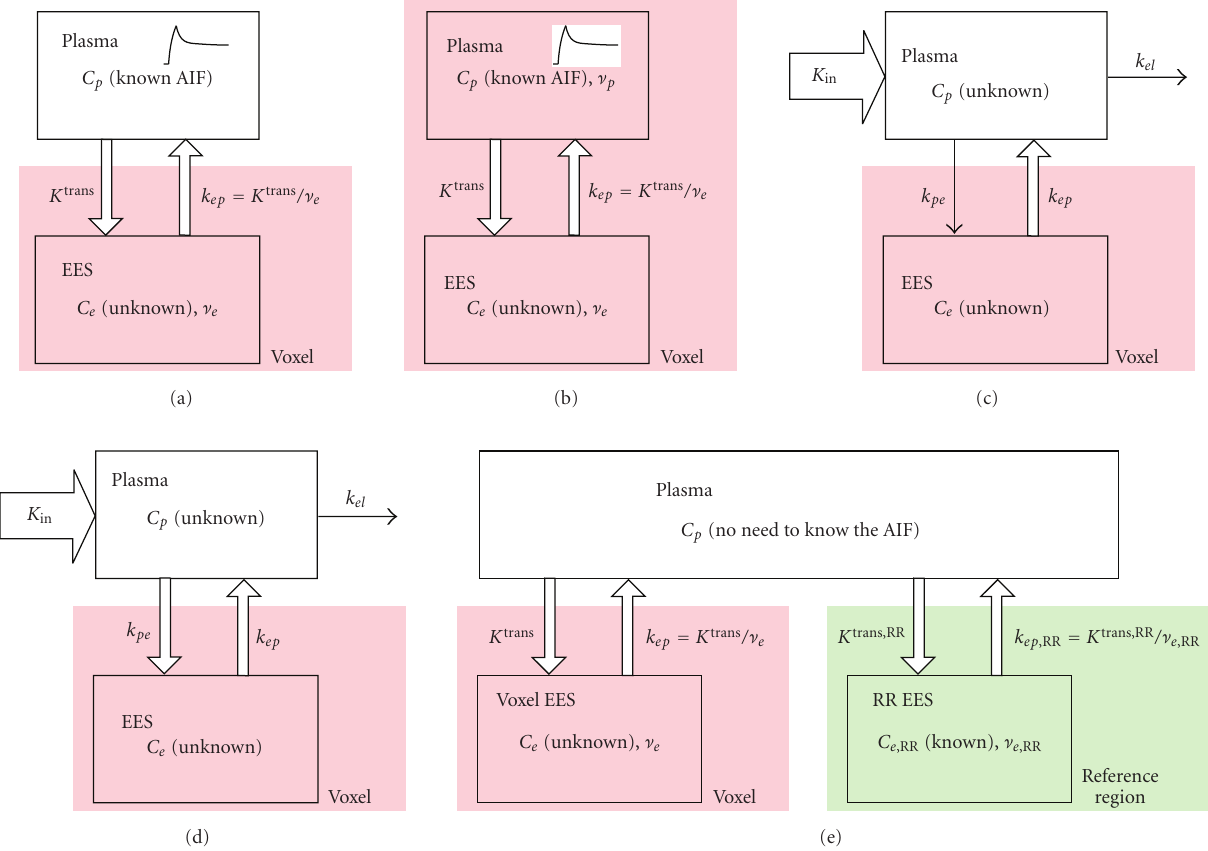
Figure 1: In the literature, several models are available for DCE-MRI pharmacokinetic analysis. The Tofts’ model ((a), also known as Kety’s or Larsson’s model) [22] models the gadolinium concentration dynamic change in a tissue voxel as the result of convolution between an exponential kernel and a measured or assumed arterial input function (AIF). A plasma term with volume fraction v p is added in the extended Toft’s model (b) [23] by the assumption that the influence of the intravascular compartment is nonnegligible. The Brix’s model (c) [24] takes the gadolinium concentration in blood plasma as another unknown variable and solves it with the tissue dynamic curve from a set of ordinary di ff erential equations. In the adjusted Brix’s model (d) [25], an oversimplified assumption in the original Brix’s model is corrected, leading to a more realistic description of the plasma signal. In the reference region model (e) [26], two dynamic curves are simultaneously measured from the target voxel and a nearby reference region with known K trans and v e values. The need for an AIF is eliminated by jointly solving two pharmacokinetic equations for target voxel and reference